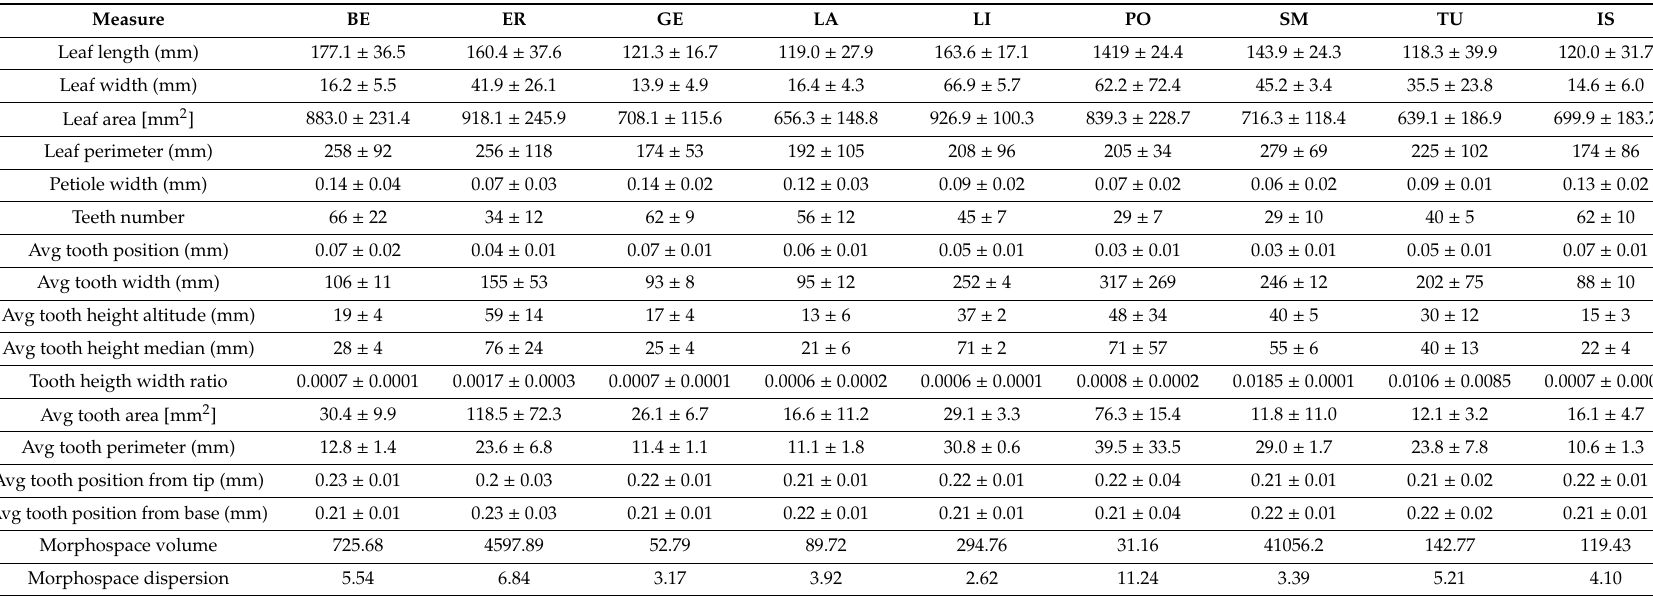
Table 2. Characters measured in leaf morphology: The average value ( ± standard deviation) of each measurement made on the leaves is reported separately for each population. The “avg” in front of the measurement name indicate that the value was used as an average value in the principal component analysis. The unit of measurement is given in square brackets. LA, IS, SM, and GE populations were from Maritime Alps; LI and BE were from Ligurian Alps; PO was from Cottian Alps and TU and ER were from Appennines. See Table 4 for populations